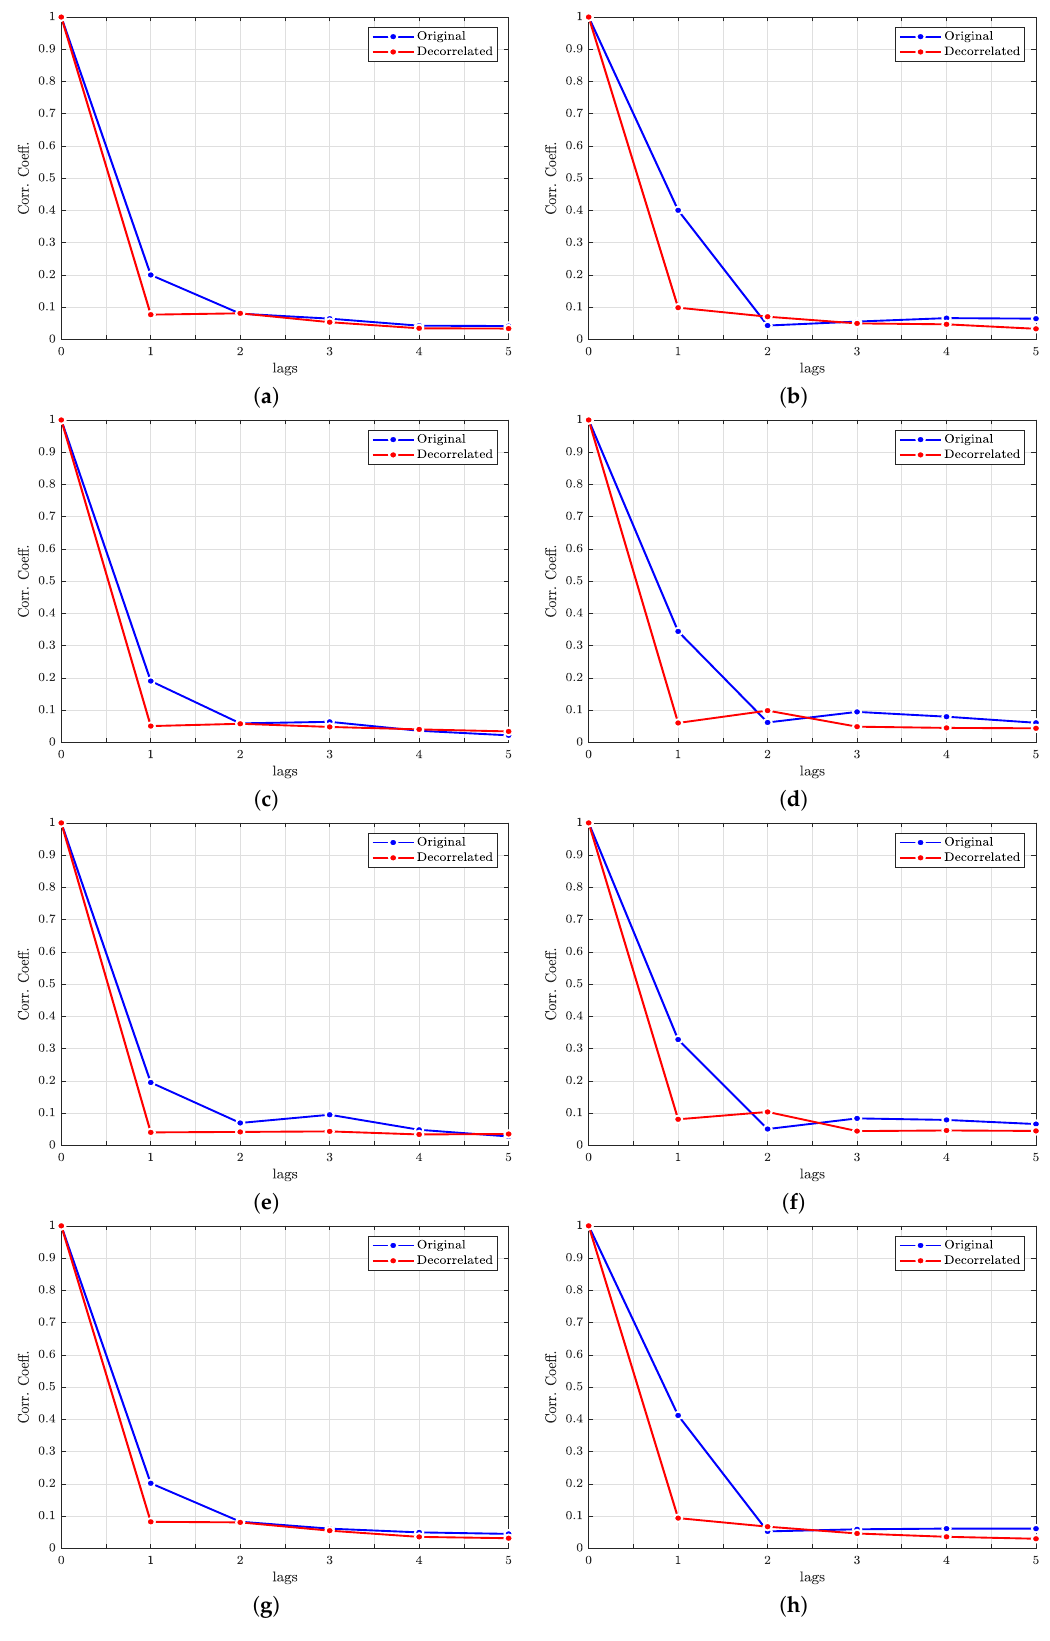
Figure 9. Speckle autocorrelation function computed over a homogeneous patch along the range direction (left column) and the azimuth direction (right column) of the original and decorrelated single-look intensity. ( a , b ) HH; ( c , d ) HV; ( e , f ) VH; ( g , h )